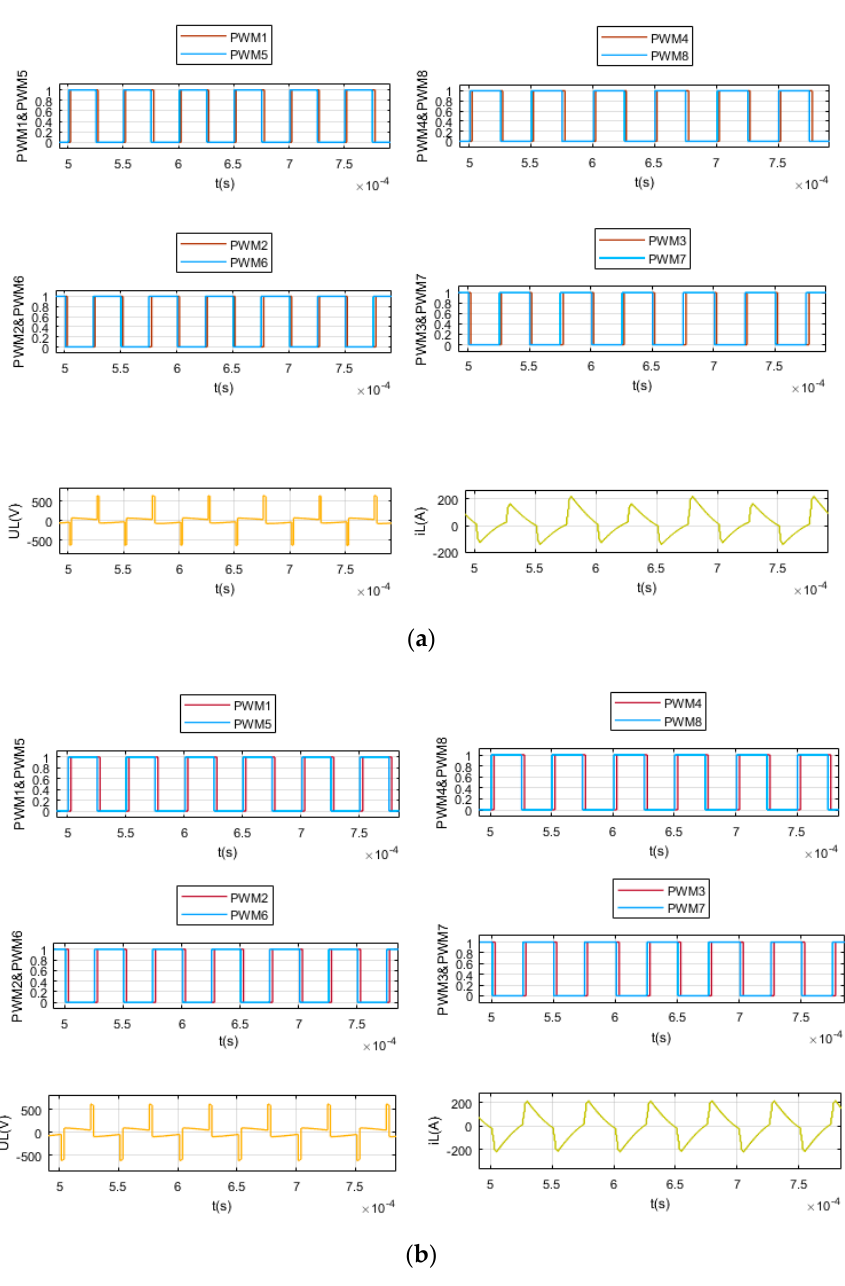
Figure A1. Detailed simulation waveform diagram of the drive signal when U dc initial voltage is 651.7 V and U o initial voltage is 75 V: ( a ) MPC only for DAB; ( b ) MPC for DAB-SC system.